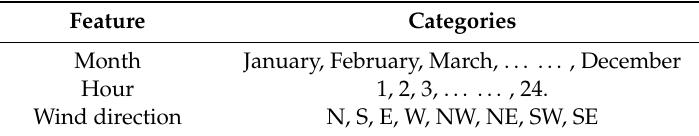
Table 5. GBDT input categorical